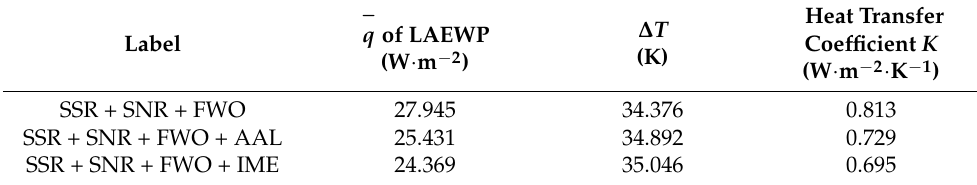
Table 10. Heat transfer coefficient of univariate improvement